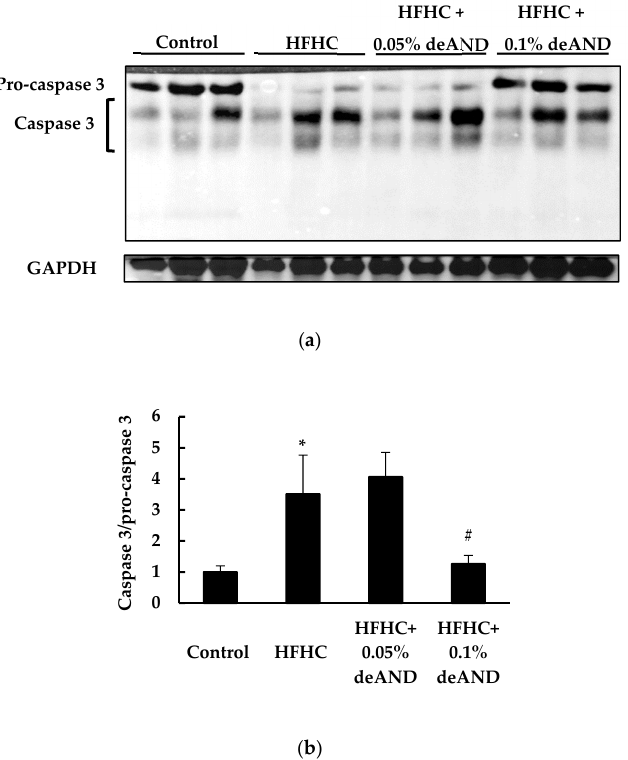
Figure 3. Western blotting analysis of apoptosis index (Caspase 3 / pro-caspase 3) in liver ( a ). The data show the effects of deAND supplementation on HFHC diet-induced apoptosis ( b ) in the liver. Glyceraldehyde 3-phosphate dehydrogenase (GADPH) served as the loading control. Active caspase 3, derived from cleavages of pro-caspase 3, was quantitated by the sum of 17 and 20 kd protein bands. The values are given as the mean ± S.D. ( n = 3). * Significantly different from the Control group, p < 0.05. # Significantly different from the HFHC group, p <